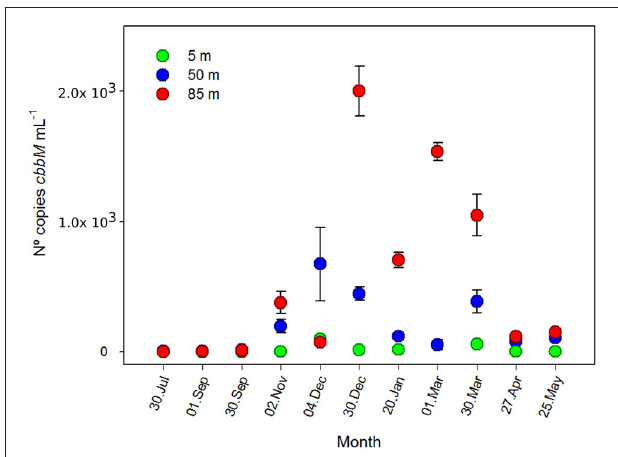
FIGURE 4 | Number of copies of cbbM gene during an annual cycle (n ◦ copies mL − 1 ± standard deviation) at 5, 50, and 85m of depth, St.